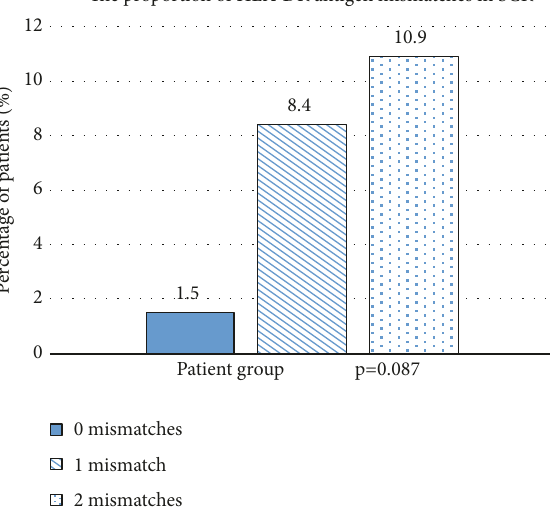
Figure3:IncidencerateofSCRindifferentmodeoftransplantation.